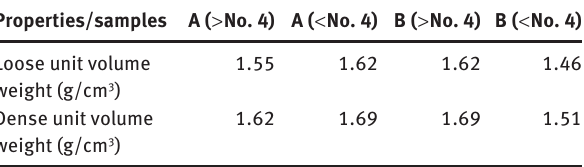
Table 4 Test results of unit volume weight.